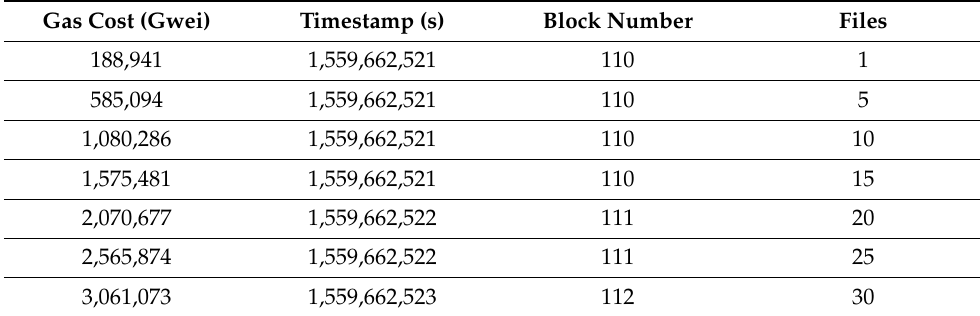
Table 1. The experimental result of the proposed firmware